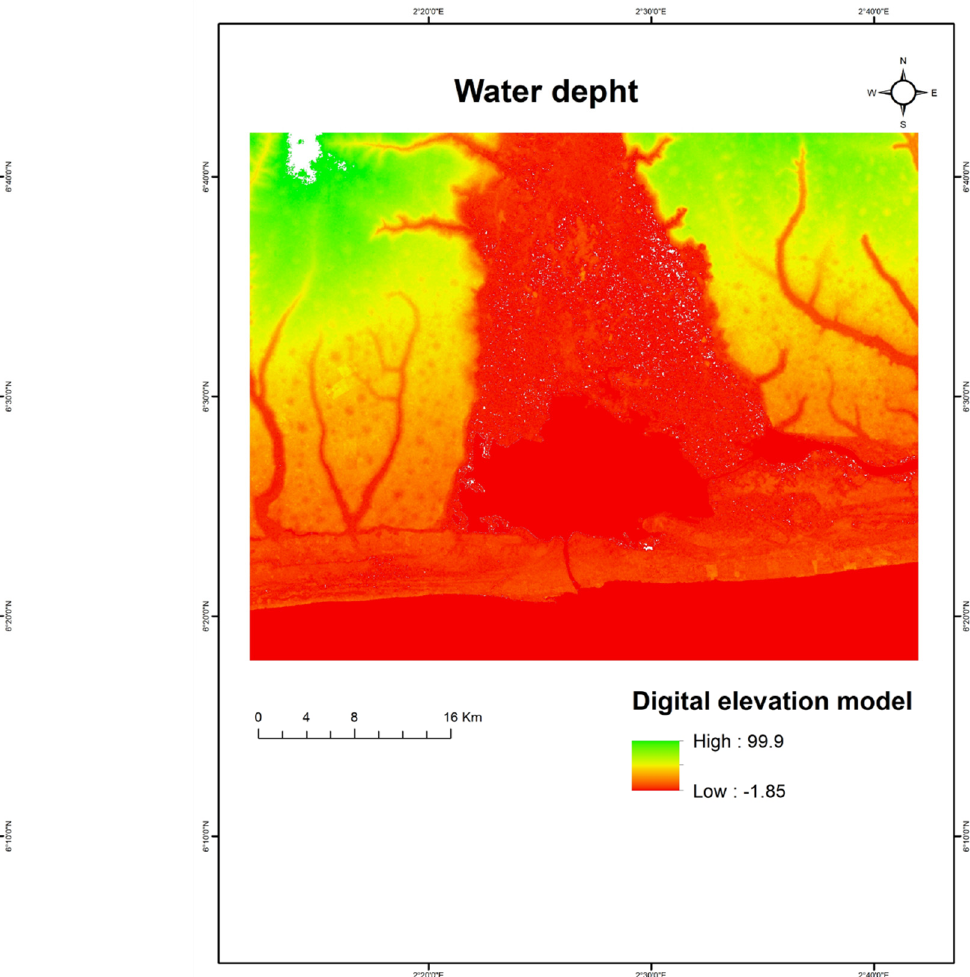
Figure 2. Classified maps of visited points and significant variables for site suitability.